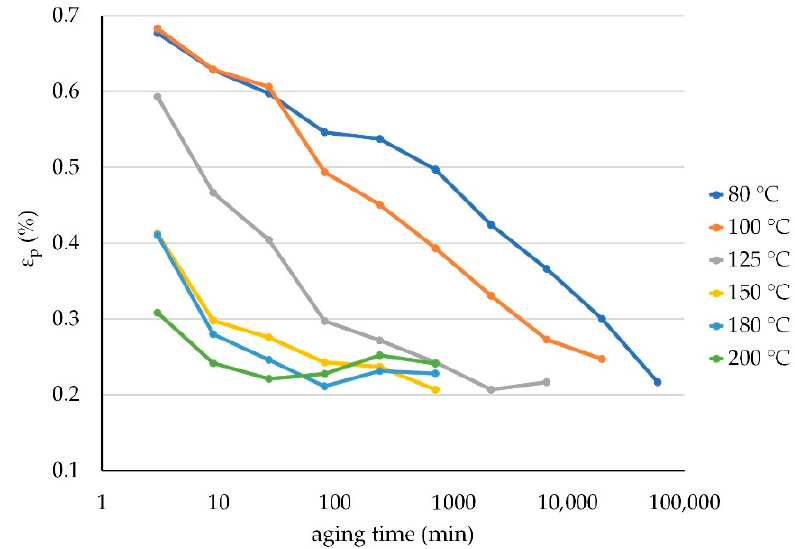
Figure 3. Plastic strain vs. aging time (Ø0.71 wire, 80–200 °C).